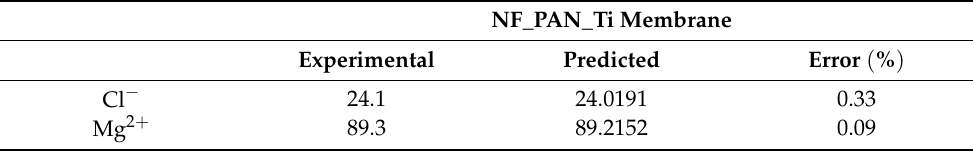
Table 5. Experimental and predicted rejections followed by error